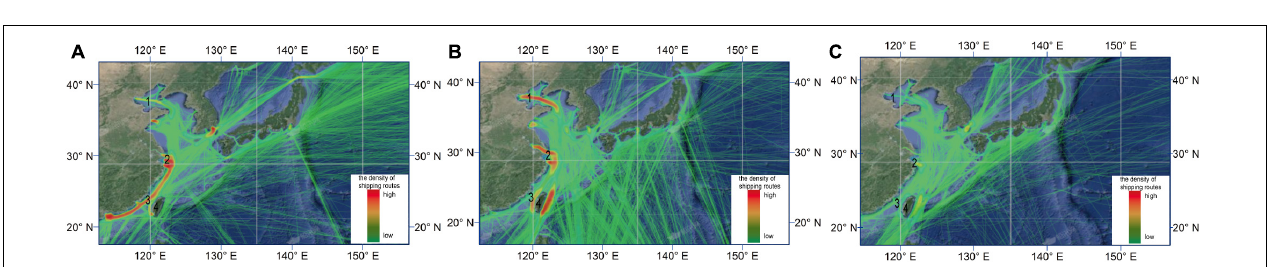
FIGURE 9 | Throughput evolution of Chinese containers, 1979–2018. The 21st century began with rapid growth, and in 2008 the volume of seaborne trade declined as a result of the global financial crisis. The vertical dashed red line indicates the year 1999 and the two horizontal red lines indicate the average annual container throughput for the periods 1979–1999 and 1999–2018, respectively. Source: China Ports Yearbook (1999–2019).